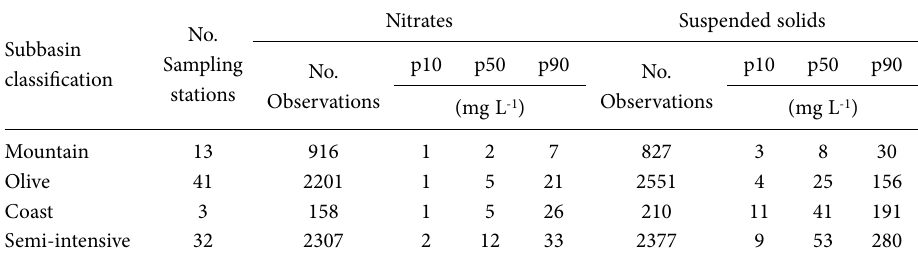
Table 1. Descriptive statistics for monthly observations at 89 sampling stations over the 9/1998- 8/2009 period and by subbasin classified according to dominant type of irrigated